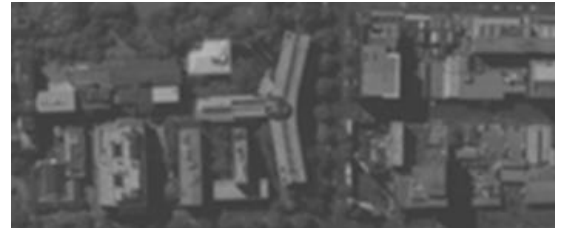
Figure 8. Nadir view for our test scene, the image dynamic was slightly changed to make details more